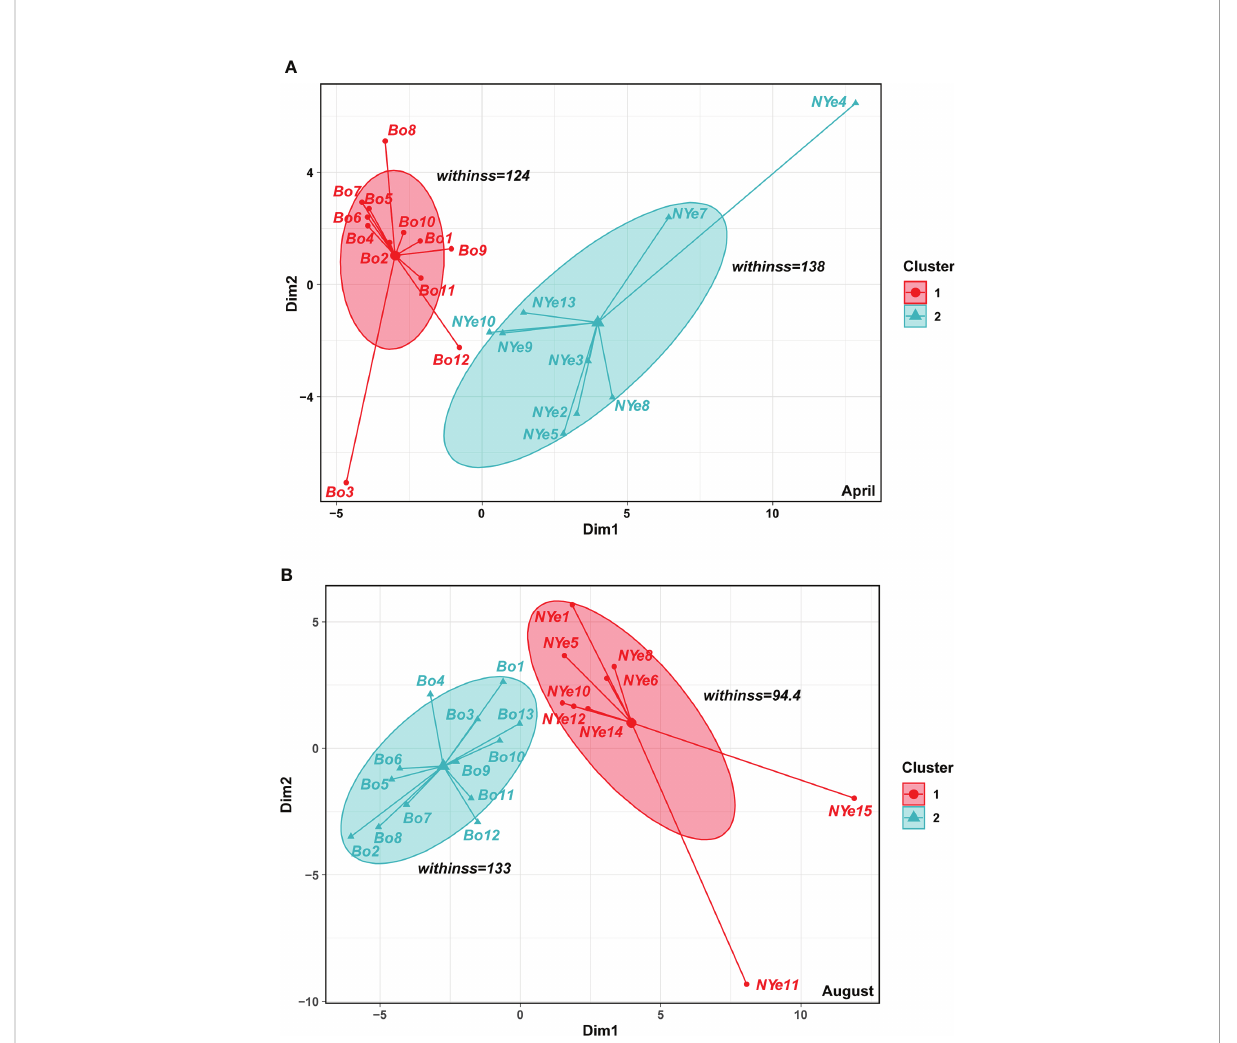
FIGURE 4 The results of k -means cluster analysis of the macrobenthic community in (A) April and (B) August of 2020, and by sea areas (Bohai Sea and northern Yellow Sea).